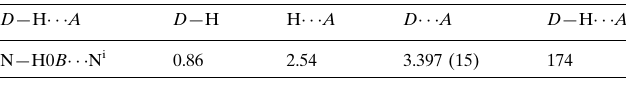
Hydrogen-bond geometry (A˚ , (cid:4)